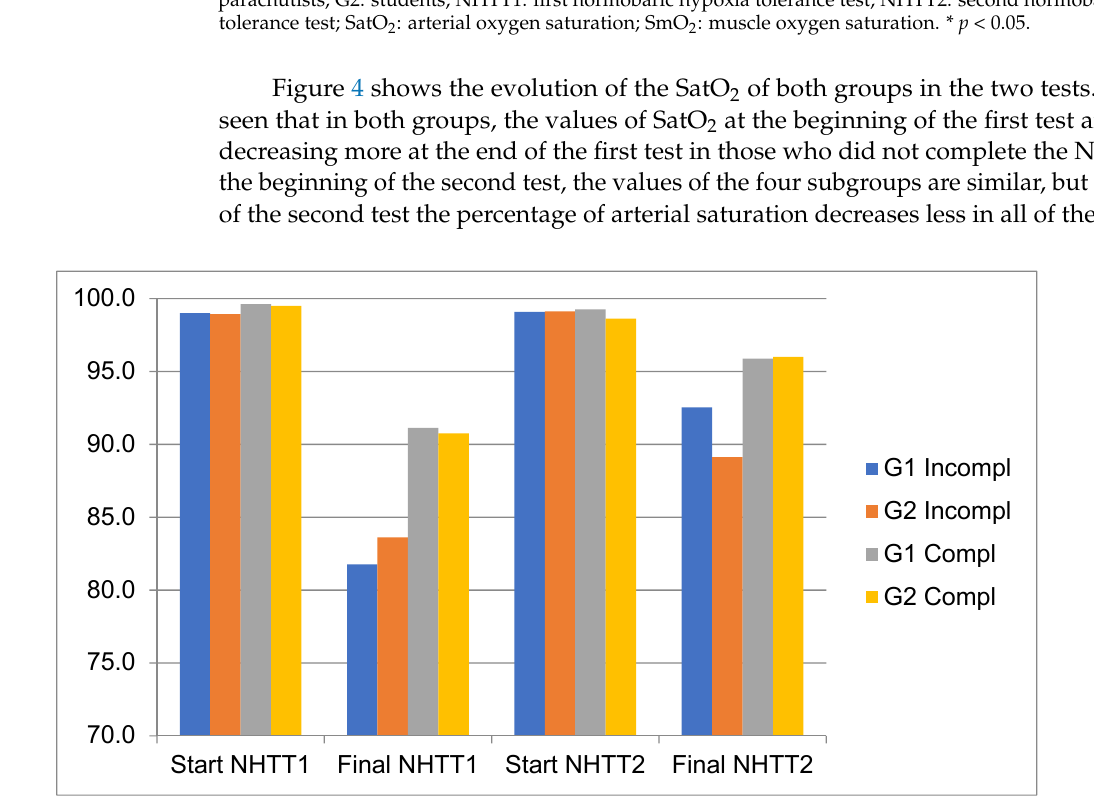
Figure 5. Evolution of SmO 2 (%) in both test and subgroups. NHTT1: first normobaric hypoxia tolerance test; NHTT2: second normobaric hypoxia tolerance test; G1 incompl: group of parachutists with incomplete test; G2 Incompl: group of students with incomplete test; G1 Compl: group of par- achutists with complete test; G2 Compl: group of students with complete test.